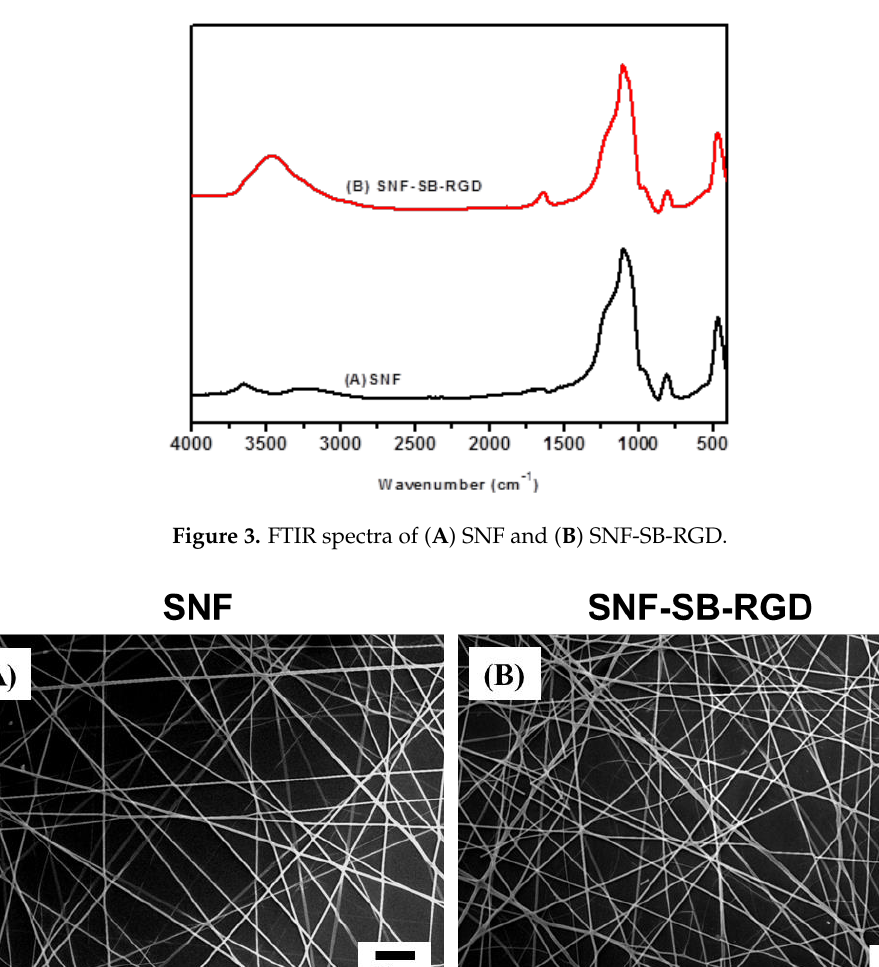
Figure 4. SEM images of ( A ) SNF and ( B ) SNF-SB-RGD. The scale bar represents 10 μm.